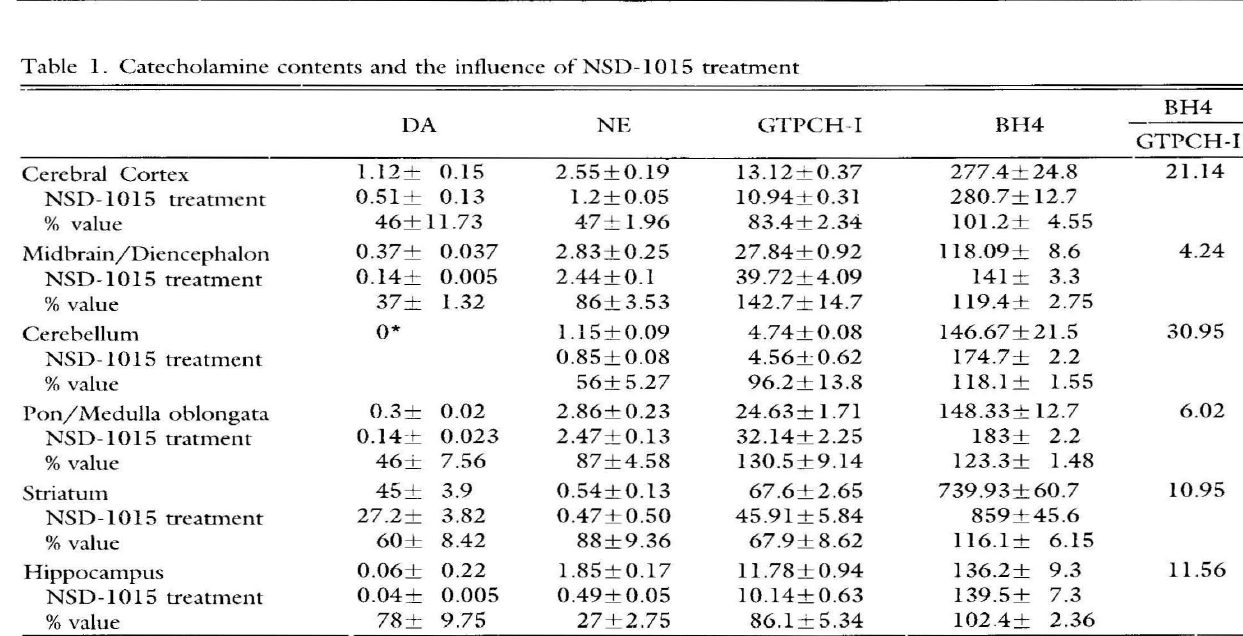
Table I. Catecholamine contents and the influence of NSD-1 0 15 treatment DA NE